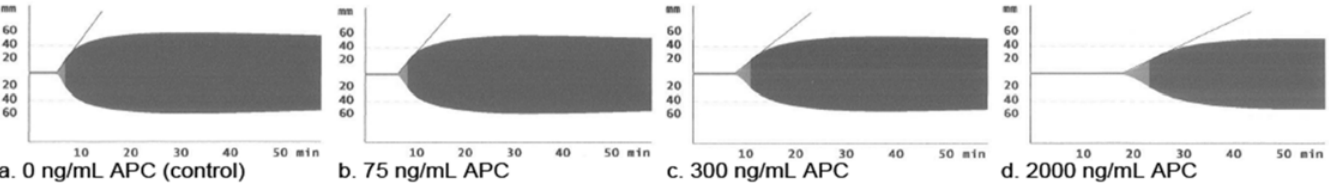
Fig 1. Characteristic ROTEM EXTEM tracings from a study subject. In every single one of the 20 subjects, as depicted here, increasing concentration of aPC produced ROTEM tracings consistent with worsening acute traumatic coagulopathy.